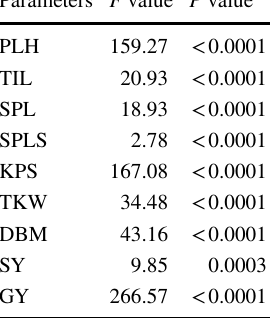
Table 2 ANOVA data of filter cake treated agronomic parameters, yield and yield components